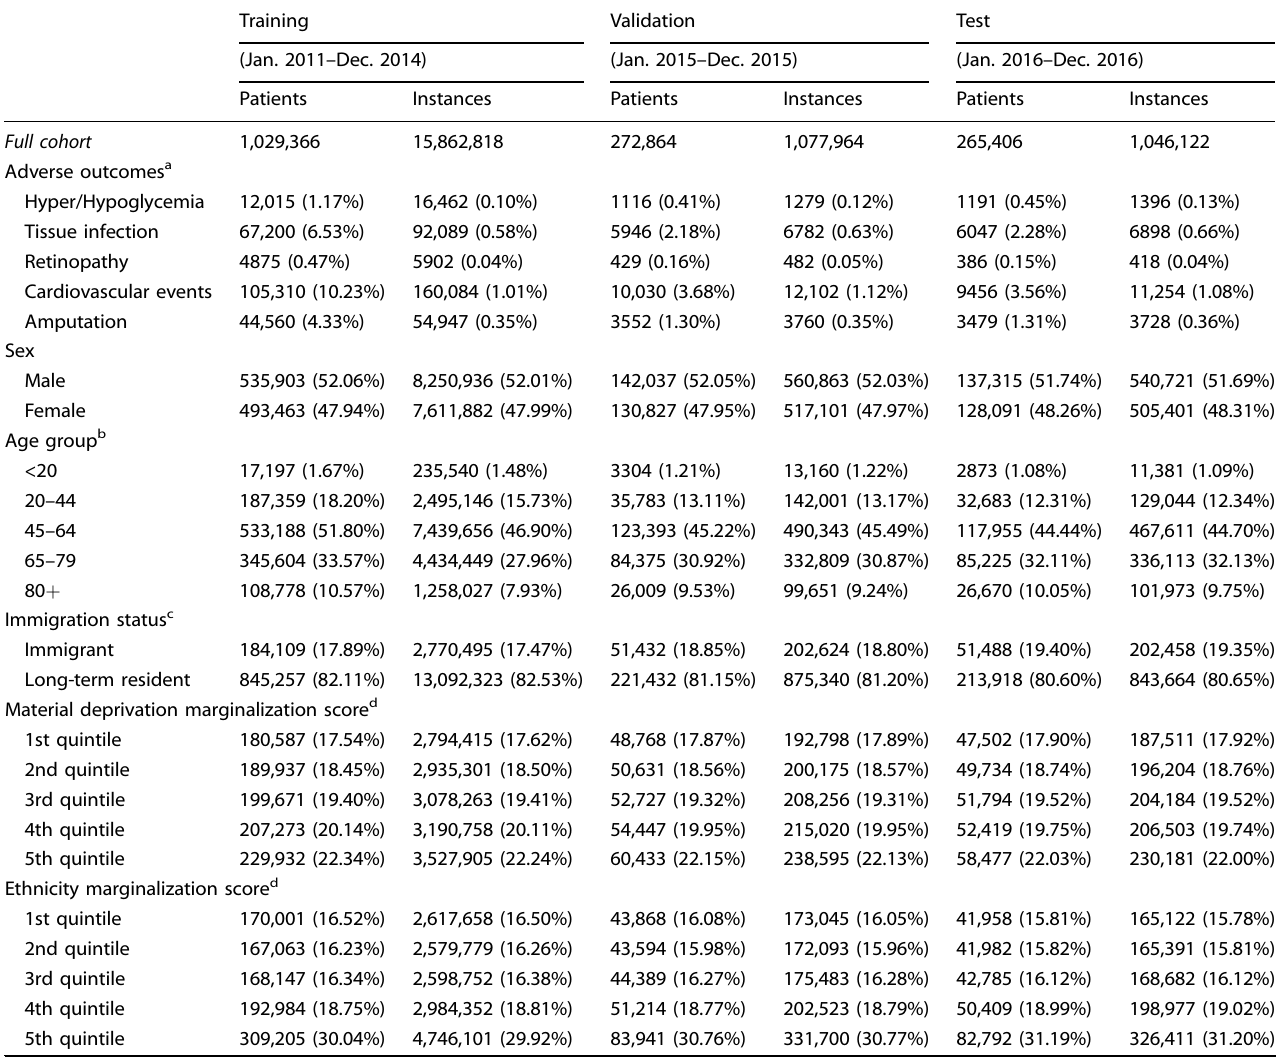
Table 1. Patient and instance counts across complications and population